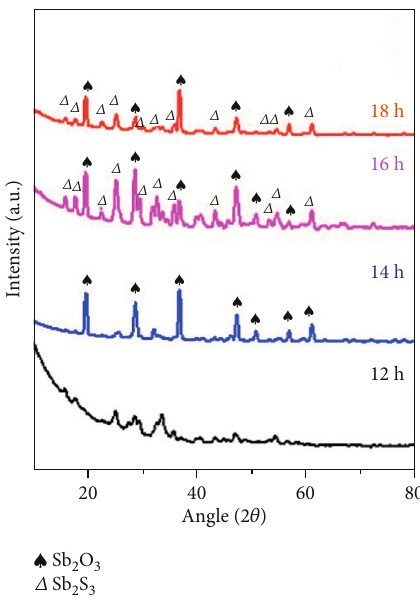
Figure 1: XRD patterns of the precipitates prepared at various reaction times.